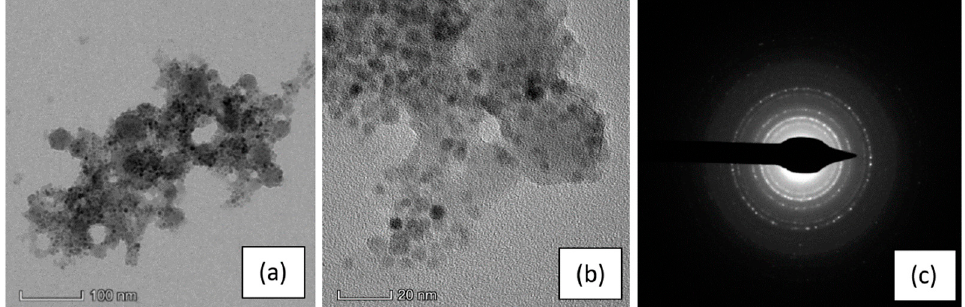
Figure 3. TEM images of a pSi microparticle after SPIONs infiltration at: ( a ) 100 nm scale and ( b ) 20 nm scale; ( c ) the SAED (selected area electron diffraction) pattern indexed as magnetite (PDF card 82–1533).